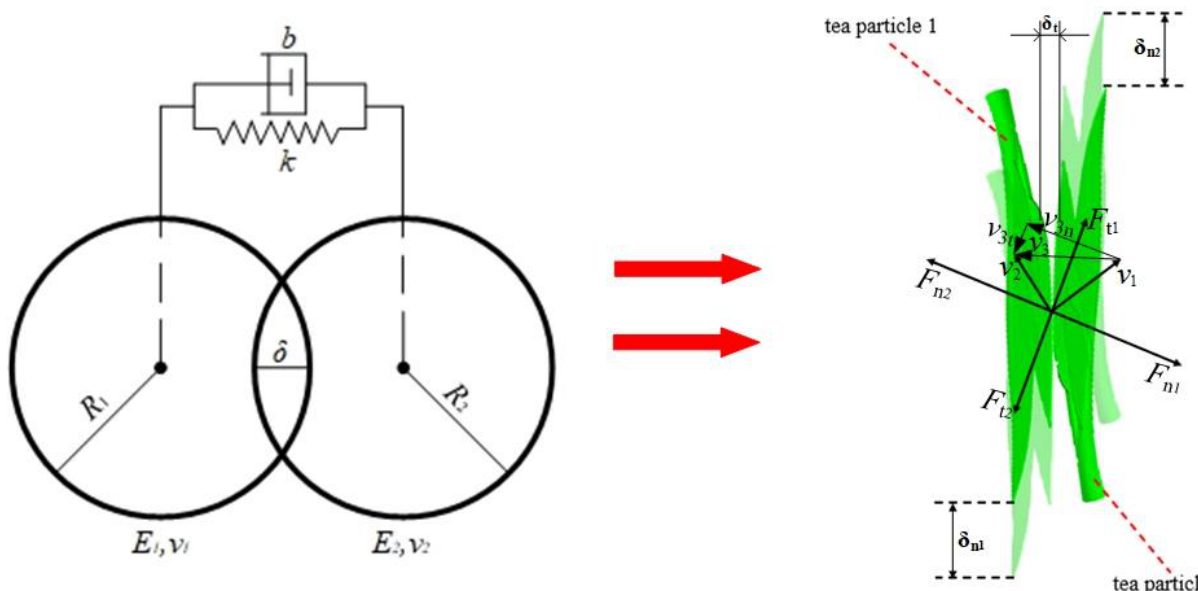
Figure 5. Force analysis of the interaction between particles of tea.